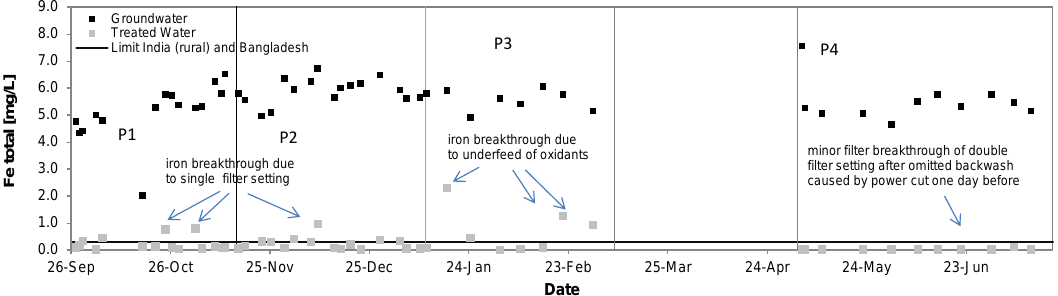
Figure 9. Iron removal performance of the Kalyani pilot system, September 2016–July 2017.